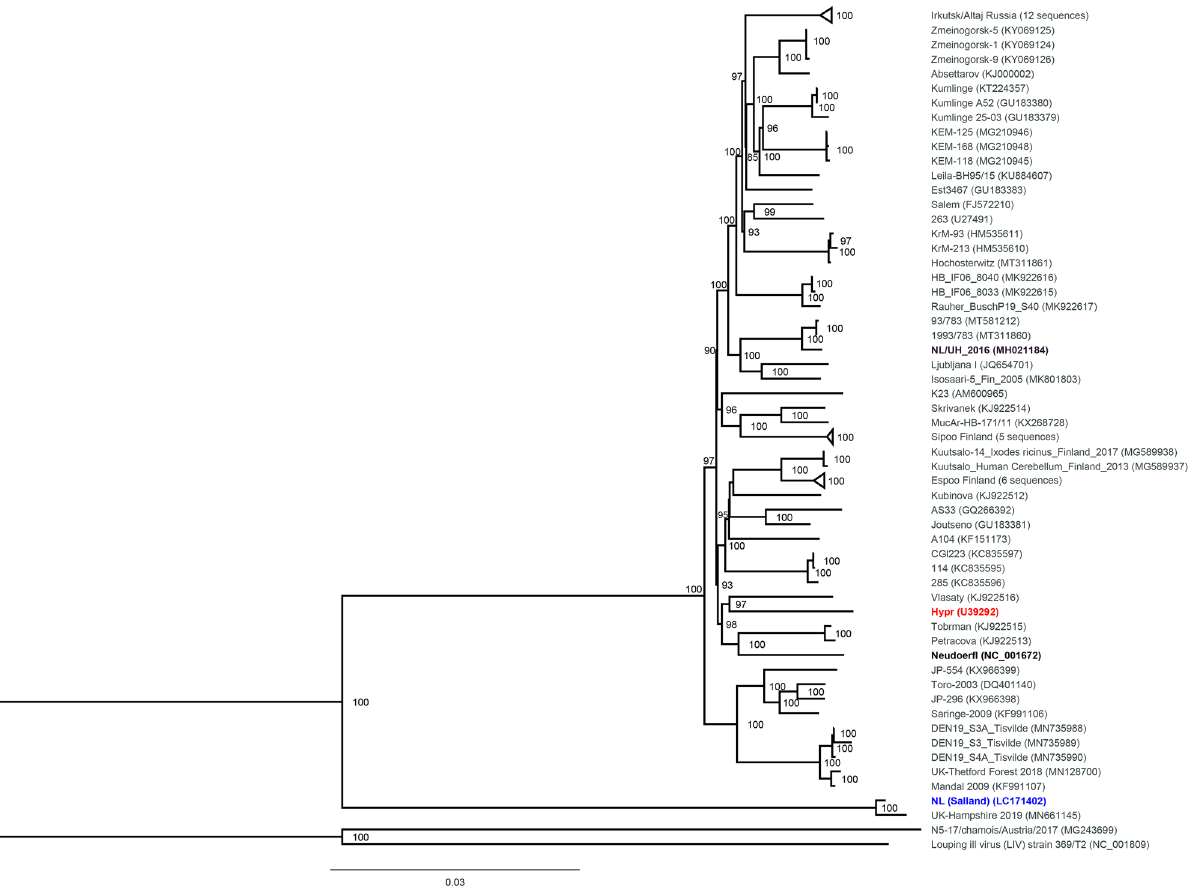
Figure 1. Maximum Likelihood Tree showing the phylogenetic relationships within the TBEV-Eu subtype. Complete genome open reading frame sequences were retrieved from GenBank and aligned in Jalview using the Mafft algorithm. The tree was constructed with IQTree using the GTR + F + R3 evolutionary model and 1000 bootstrap replicates. The resulting tree was visualized and edited in FigTree. The tree was rooted using Louping Ill Virus and N5-17/chamois/Austria/2017, a strain that was annotated as a TBEV sequence in GenBank but was found to be more closely related to LIV, as the outgroup. All bootstrap values ≥ 70 are shown. The two TBEV sequences detected in the Netherlands plus the two reference strains used in this study are highlighted; Salland in blue, NL/UH in purple, Neudoerfl in black and Hypr in